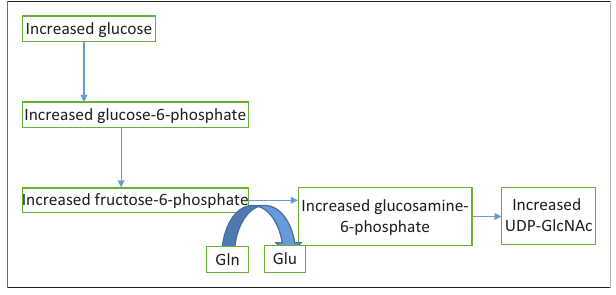
FIGURE 3: The hexosamine pathway. The flux of fructose-6-phosphate into the hexosamine pathway is increased in diabetes. Activation of hexosamine is implicated in apoptosis of retinal capillary cells in diabetes. Glutamate (Gln) and cysteine (Glu) are the cofactors for synthesis of glycosyl side chains for proteins and lipids.